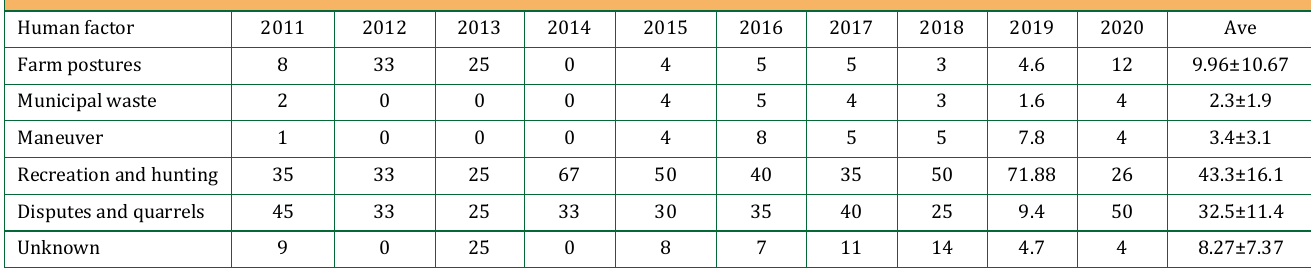
Table 2: Various human factors of fire from 2011 to 2020